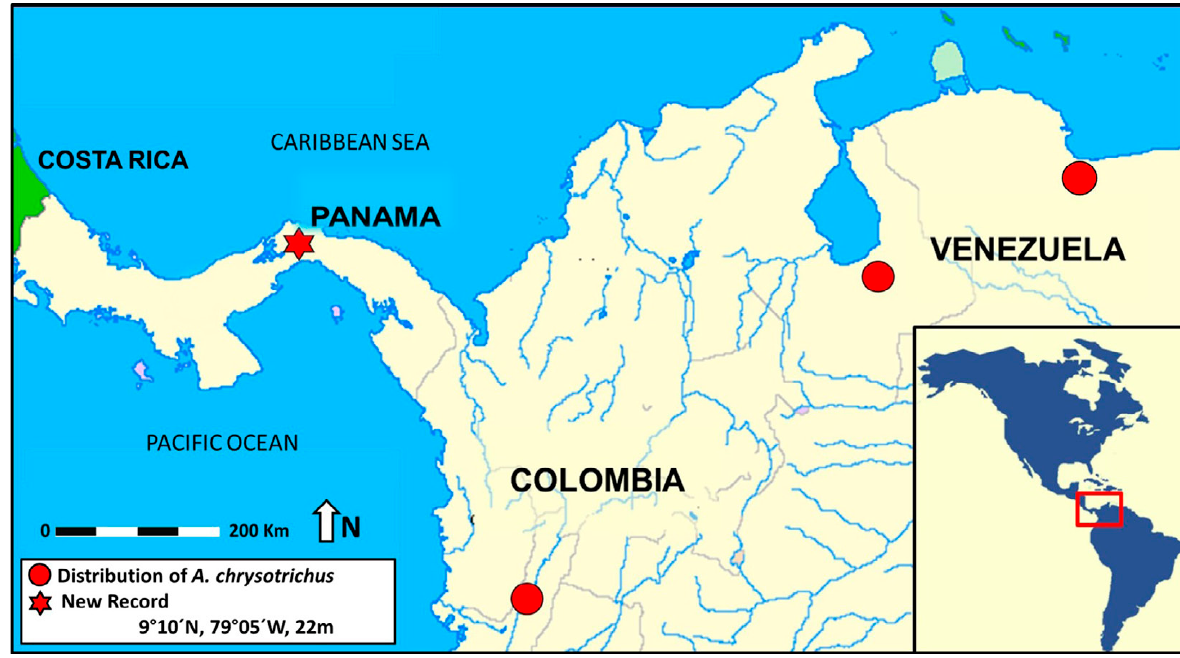
Figure 2. Map showing the known distribution of the Aulacophilus chrysotrichus Antropov, 1999, including first record from Panama.